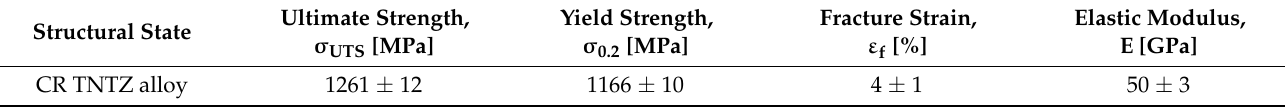
Table 3. Mechanical characteristics of CR TNTZ alloy.